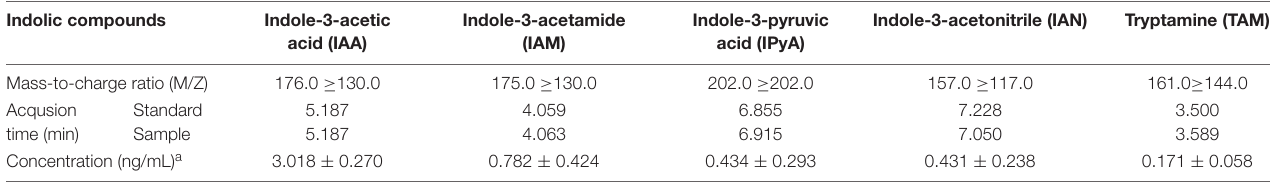
TABLE 1 | HPLC-MS/MS analysis of indolic compounds produced by B. pyrrocinia JK-SH007 in TSB medium. Indolic compounds